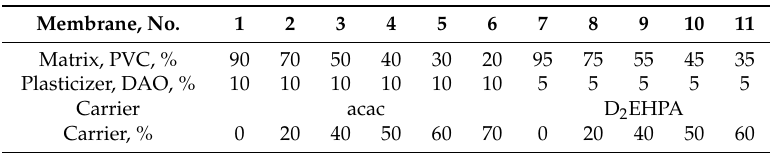
Figure 1. Structure of acetylacetone ( A ) and di(2-ethylhexyl) phosphoric acid ( B ). Table 1. Compositions of investigated membranes.